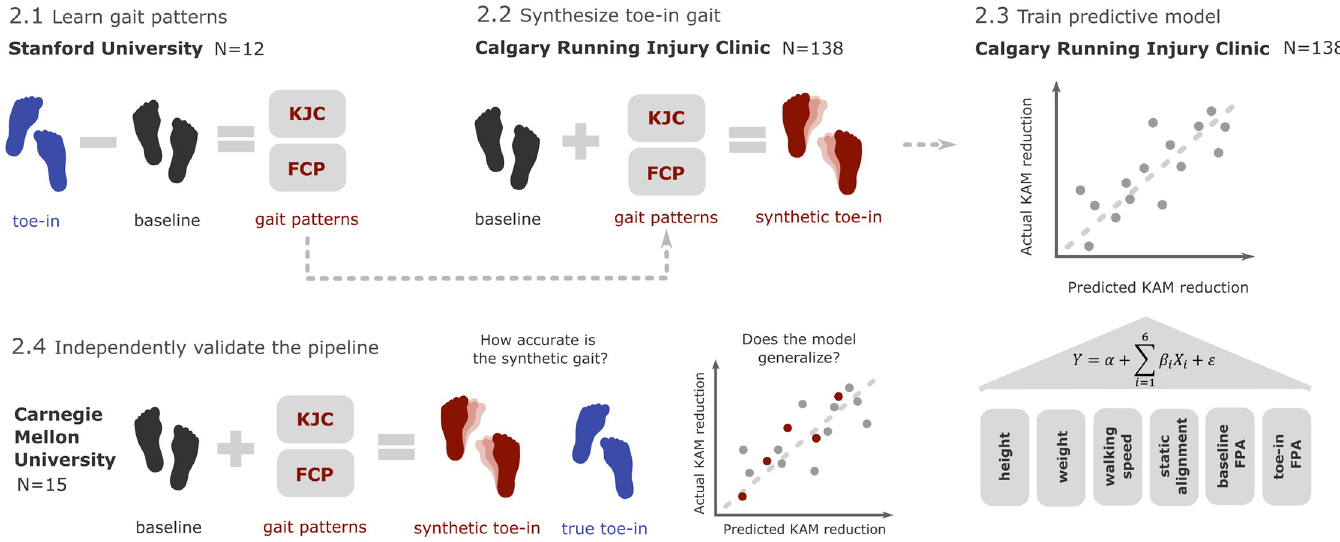
Fig 2. Study overview. This study focused on building a regression model that uses minimal clinical data to predict the extent of first peak KAM reduction after toe-in gait retraining. Given the lack of large datasets that contain both baseline and toe-in gaits for the same patient, we generated this dataset synthetically. Gait patterns of knee joint center (KJC) and foot center of pressure (FCP) learned from a ground-truth dataset (N = 12) with both baseline and toe-in gait trials (2.1, Stanford University dataset) enabled the creation of extensive synthetic toe-in data (N = 138) from a dataset that contained only baseline gait trials (2.2, Calgary Running Injury Clinic dataset). A regression model using height, weight, walking speed, limb alignment, baseline FPA, and toe-in FPA was then built to predict KAM reduction (2.3). Both the synthetic data generation approach and the predictive model were tested using data (N = 15) collected by a separate research group (2.4, Carnegie Mellon University dataset).